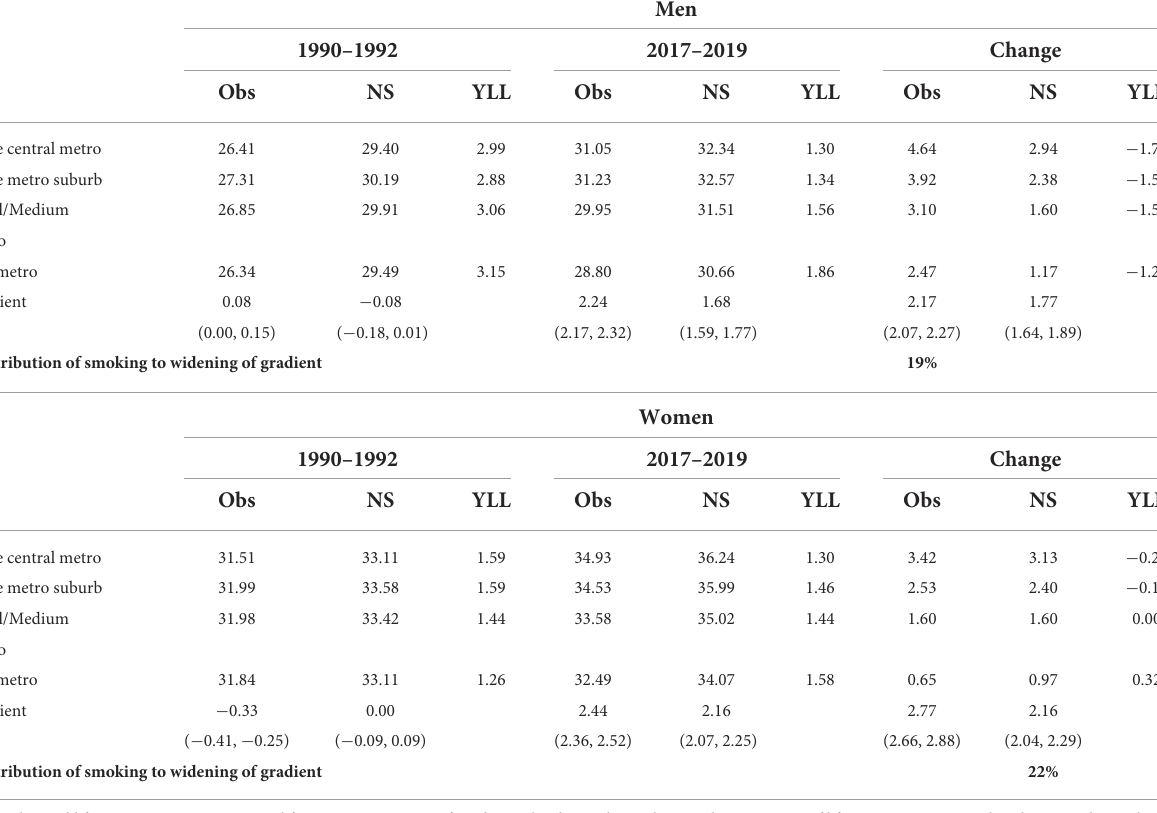
TABLE 1 Life expectancy at age 50 with and without smoking-attributable mortality by sex and metropolitan category,